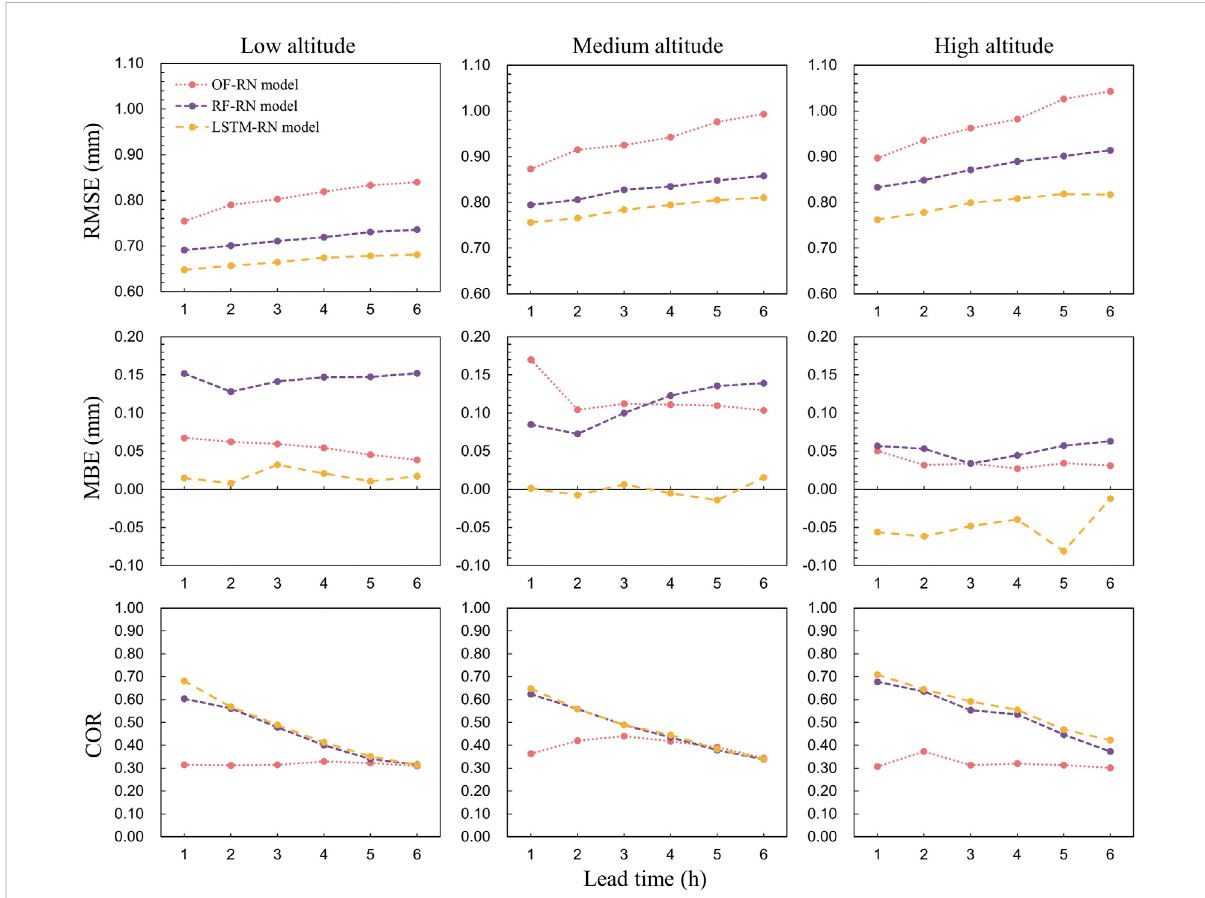
FIGURE 8 Comparison of RMSE, MBE, and COR of three types of models at different lead times and